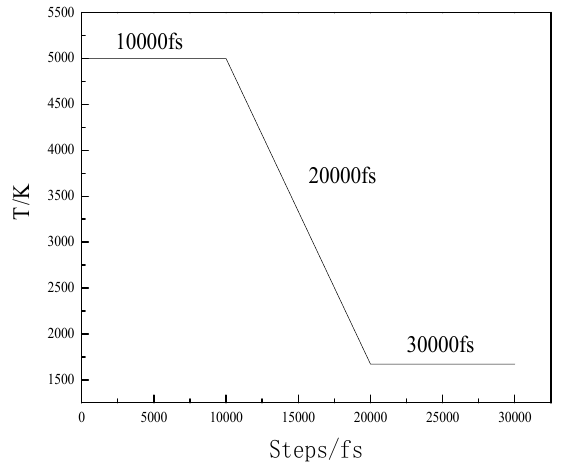
Figure 3. Variation in temperature with time.